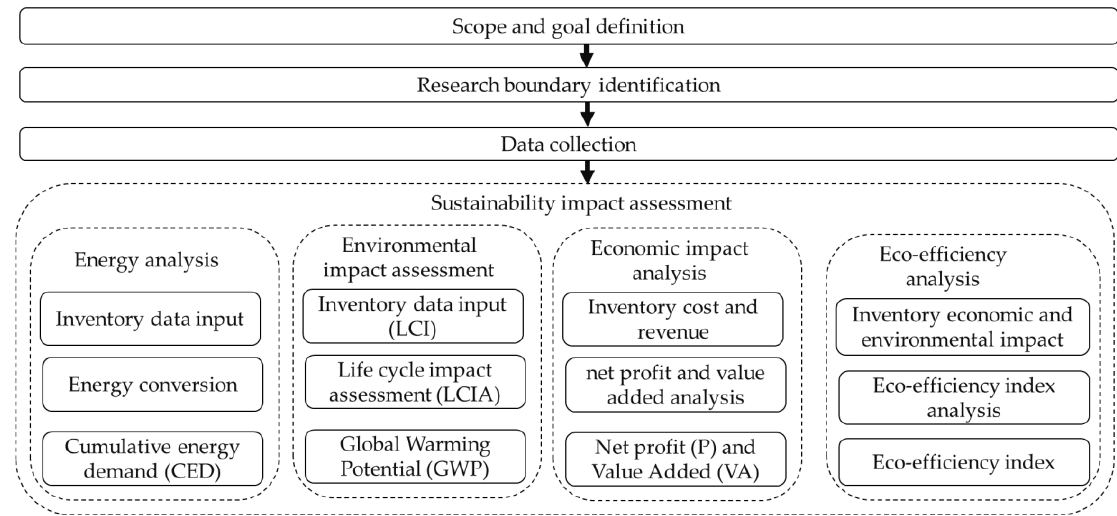
Figure 3. Schematic representation of the research stages.